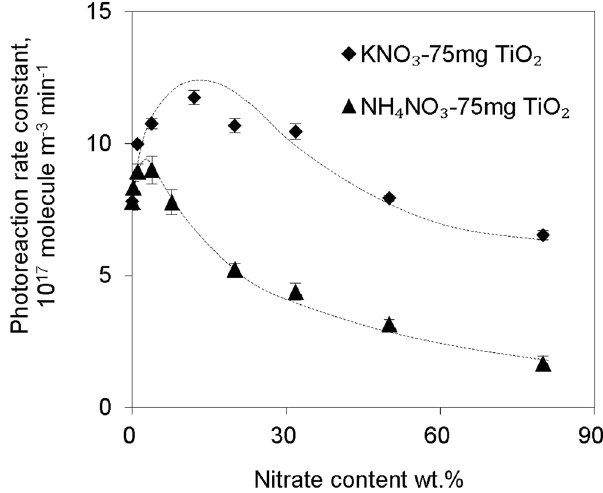
Figure 3. Variations of photoreaction rate constants with nitrate content. Formaldehyde photoreaction rate constants on